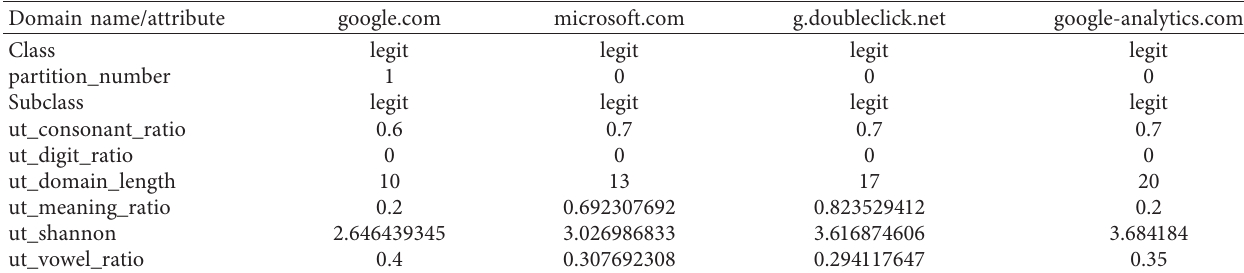
Figure 4: 3D diagram of PCA. Table 1: Domain name data attributes along with attribute value calculation.